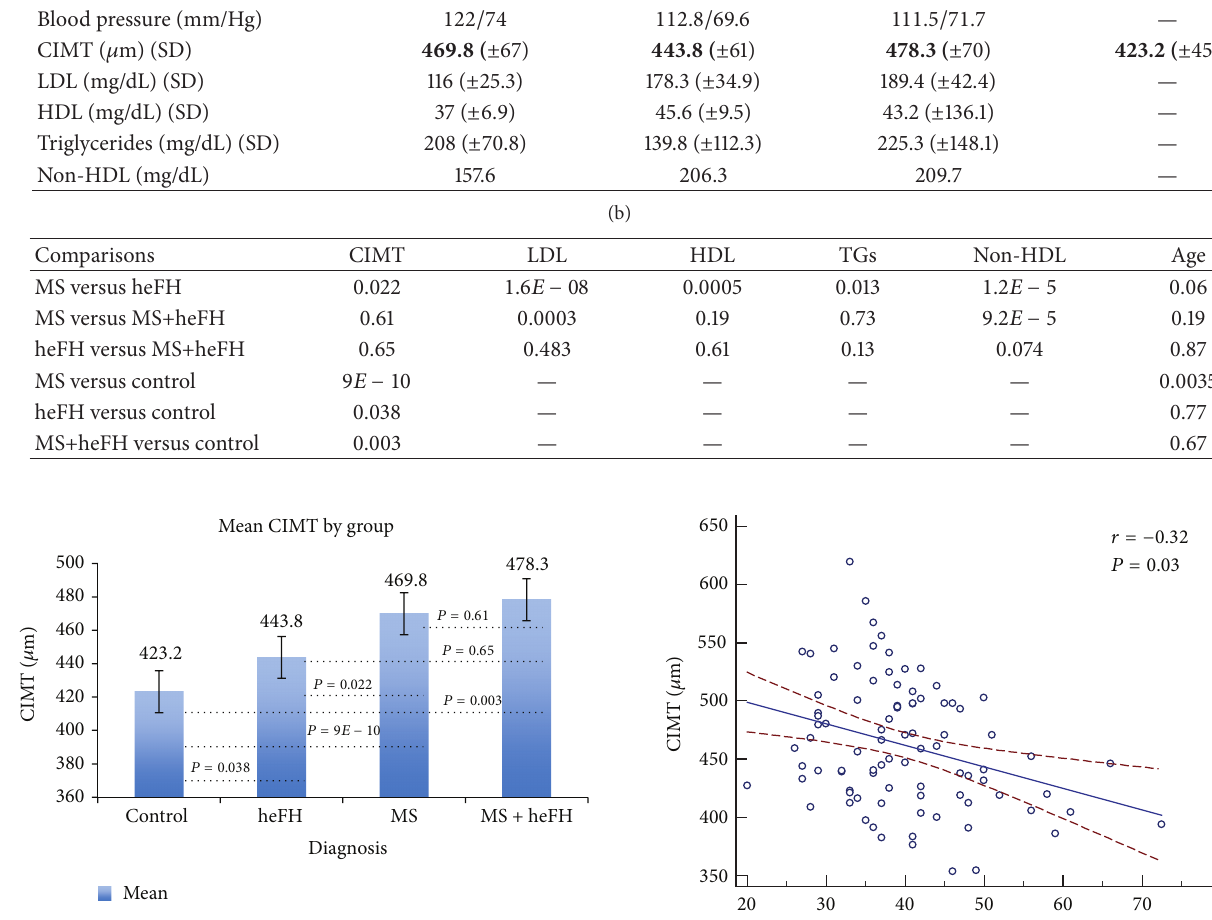
Figure 1: Mean CIMT is plotted for the control and disease cate- gories. P values are shown comparing the several disease categories and the control. One SD is indicated by a single bar. Figure 2: CIMT in